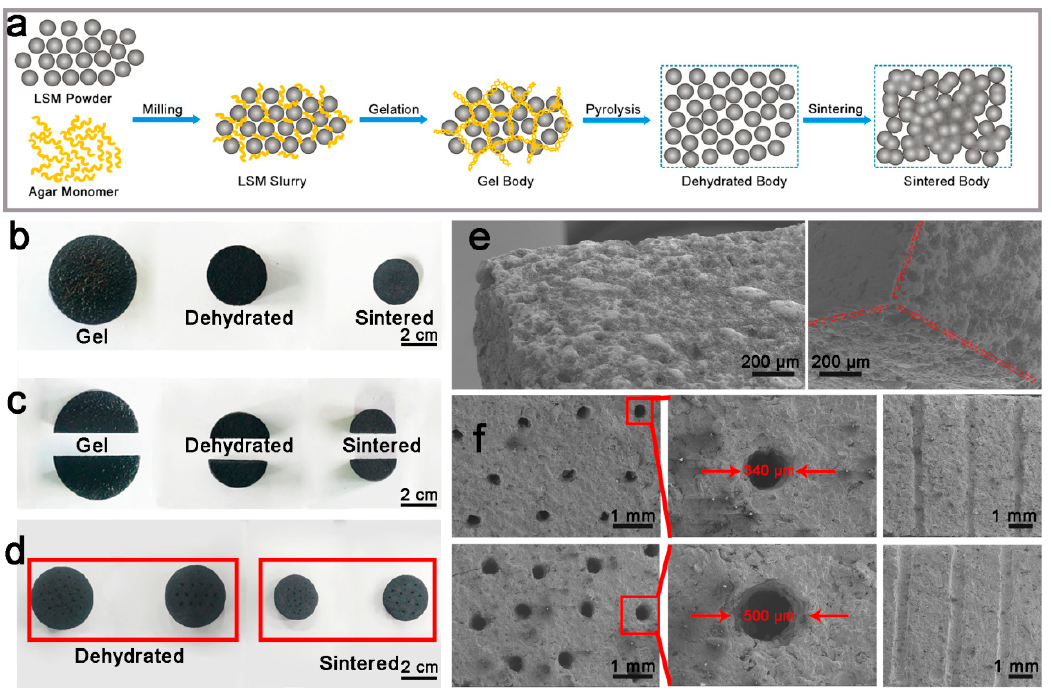
Figure 1. ( a ) Schematic drawing of the fabrication of lanthanum strontium manganite (LSM) ceramics via agar gel casting and high temperature sintering; ( b ) the top view of gel, dehydrated and sintered LSM cylinders, respectively; ( c ) the top view of the cut gel, dehydrated and sintered body, respectively; ( d ) the top view of the drilled gel bodies with different hole-diameters after dehydration and high-temperature sintering treatment, respectively; ( e ) SEM images of the cut gel body after high-temperature sintering treatment; ( f ) the SEM images of the drilled gel bodies with different hole-diameters after high-temperature sintering treatment, the magnified holes and the cross sections, respectively.